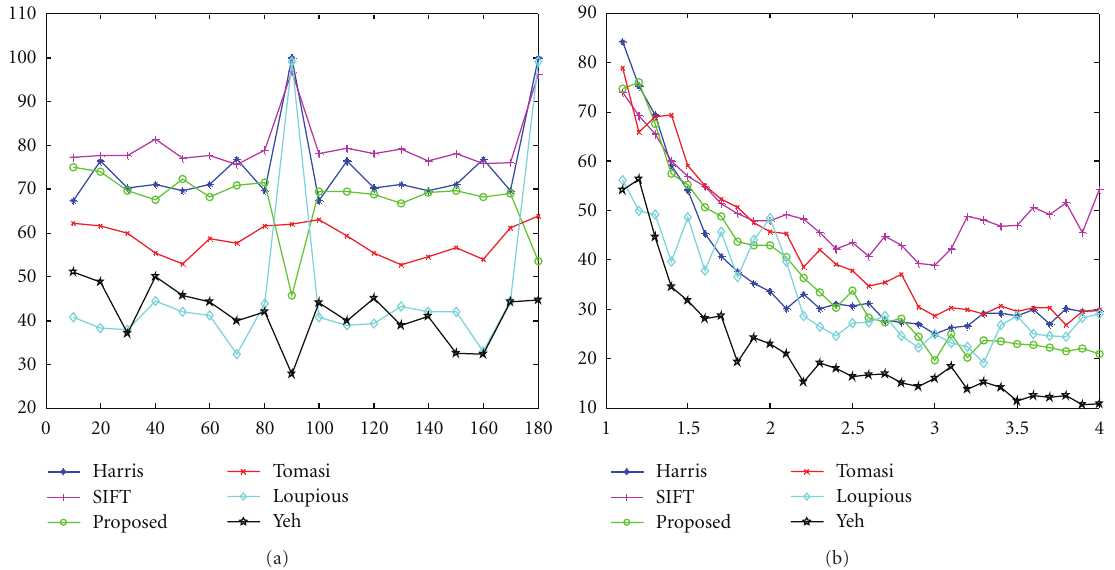
Figure 10: Plot for the repeatability rate as a function of (a) rotation angle and (b) change in scale.